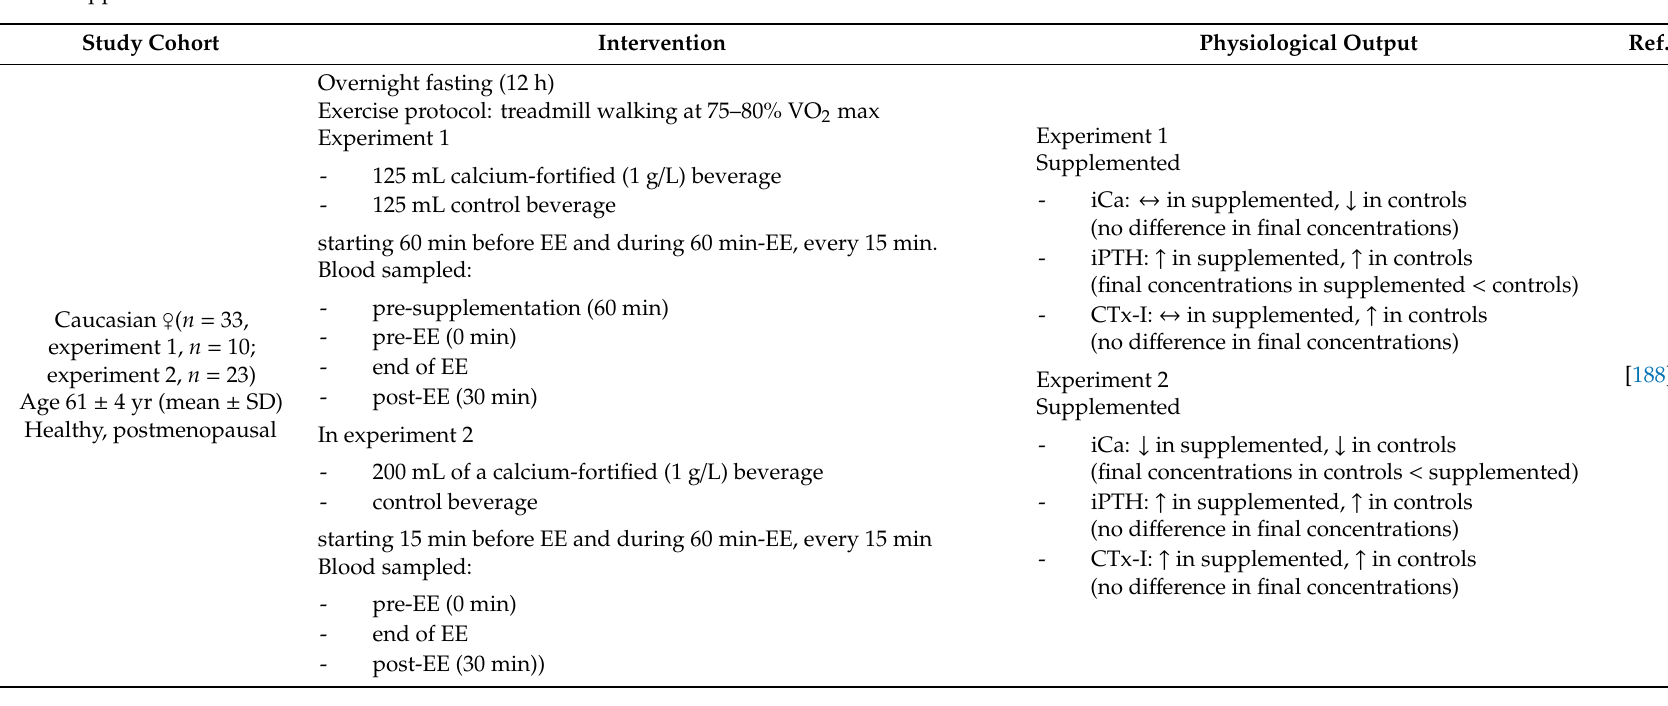
Table 3. Regulation of PTH secretion and PTH-dependent calcium-phosphate metabolism during acute exercise in humans in relation to calcium / vitamin D